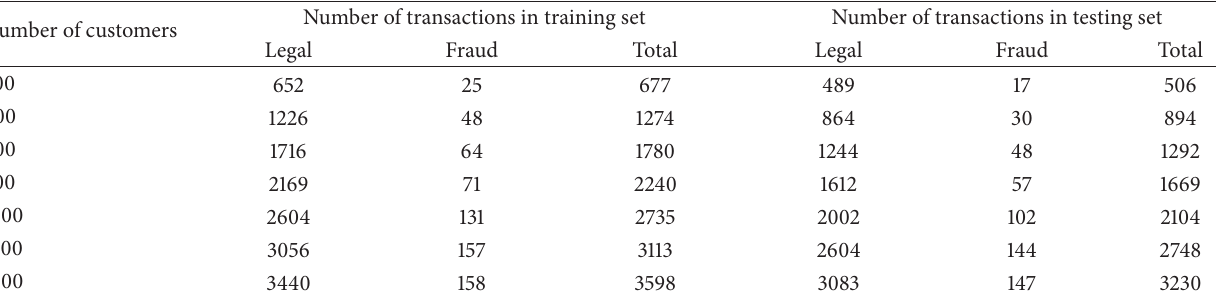
Table 1: Imbalanced data.